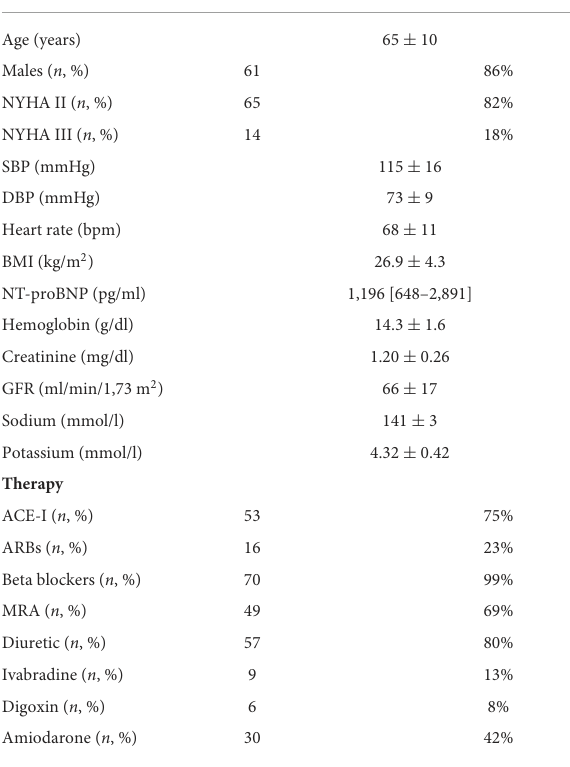
TABLE 1 Basal characteristics of the retained study population ( n = 71).